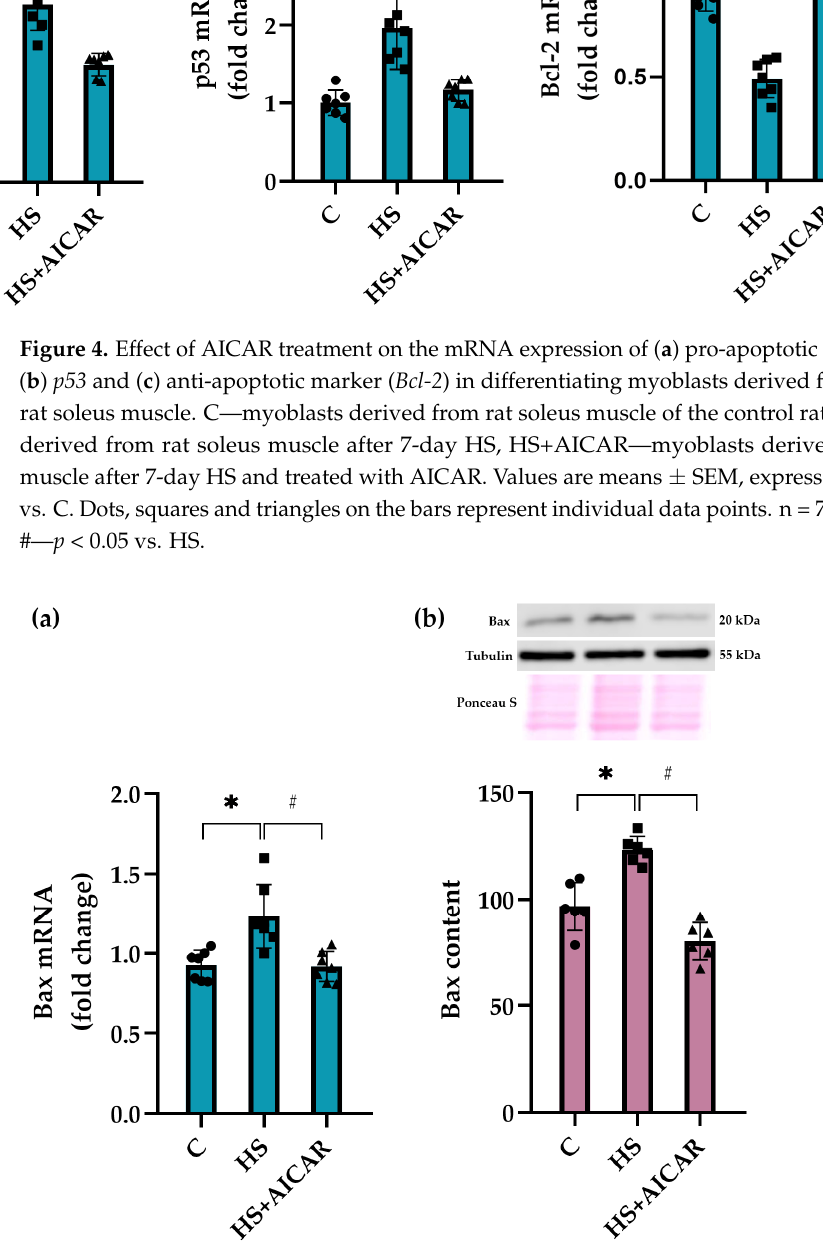
Figure 4. Effect of AICAR treatment on the mRNA expression of ( a ) pro-apoptotic markers ( caspase- 9 , ( b ) p53 and ( c ) anti-apoptotic marker ( Bcl-2 ) in differentiating myoblasts derived from the atrophied rat soleus muscle. C—myoblasts derived from rat soleus muscle of the control rats, HS— myoblasts derived from rat soleus muscle after 7-day HS, HS+AICAR—myoblasts derived from rat soleus muscle after 7-day HS and treated with AICAR. Values are means ± SEM, expressed as fold changes vs. C. Dots, squares and triangles on the bars represent individual data points. n = 7, *— p < 0.05 vs. C; # – p < 0.05 vs. HS.